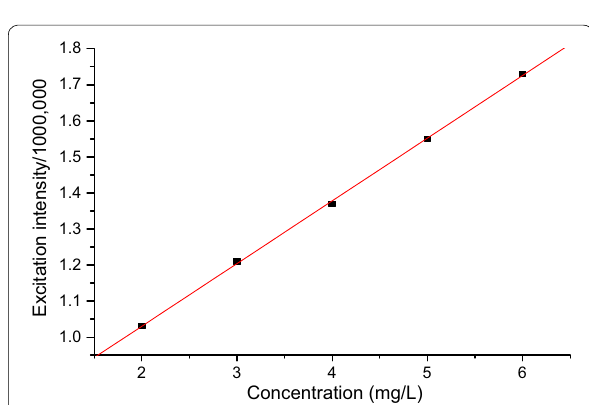
Fig. 6 Graph of concentration vs maximum fluorescence excitation intensity for trigonelline standard dissolved in water Table 1 Amount of alkaloids in green coffee